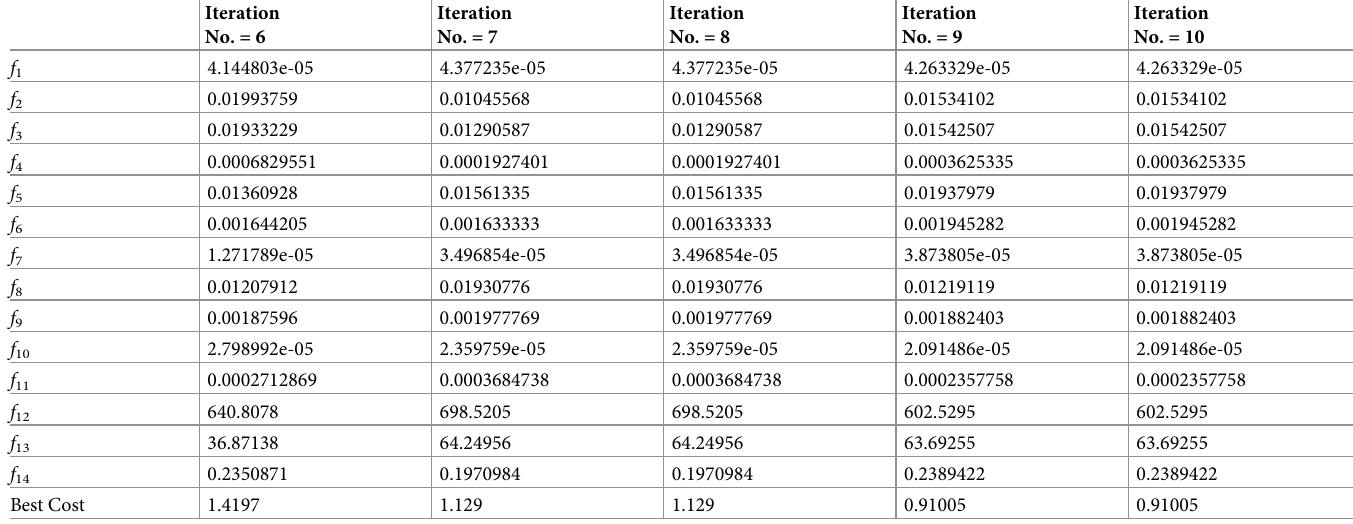
Table 2. The results when using PSO algorithm